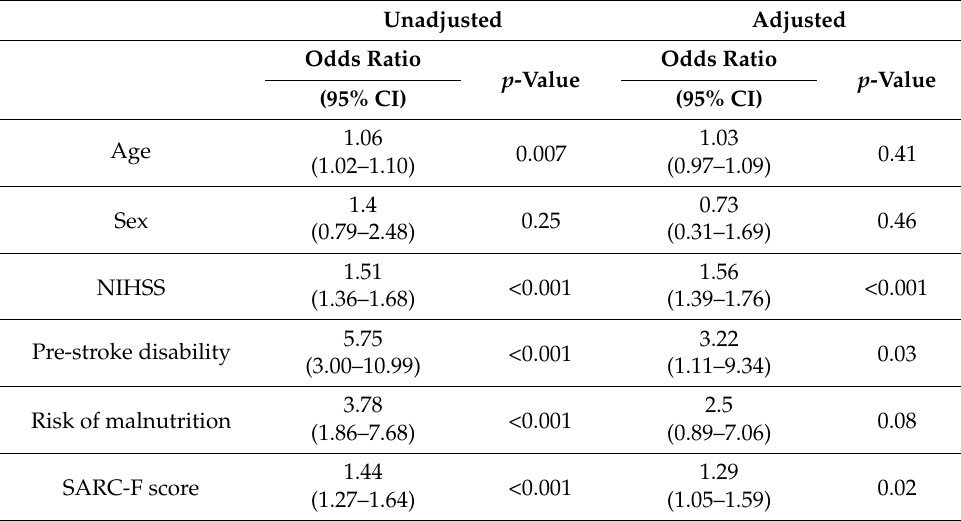
Table 3. Logistic regression analysis of poor functional